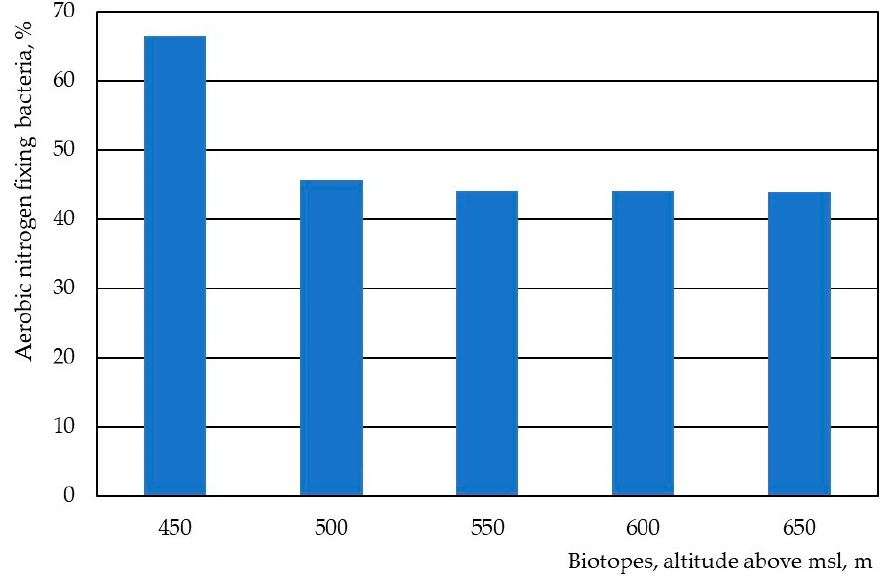
Figure 2. Aerobic nitrogen-fixing bacteria (%) in the soils of forest ecosystems. The data are statisti- cally significant, p < 0.05, x ± SD, n = 4.